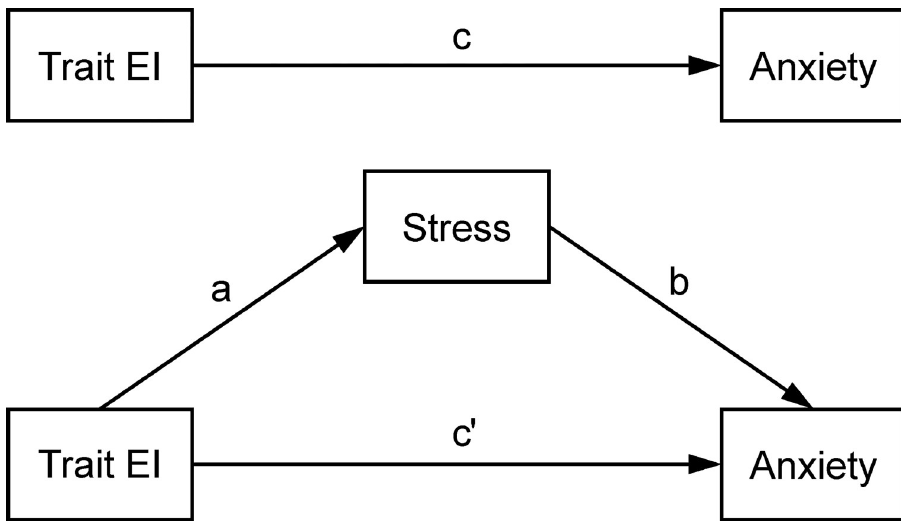
Fig 1. Mediation model of stress on the association of trait EI with anxiety. a : the association of trait EI with stress; b: the association of stress with anxiety after controlling for the predictor variable; c: the total effect of trait EI on anxiety; c 0 : the direct effect of trait EI on anxiety after adding stress as a mediator. c = ab+c 0 .